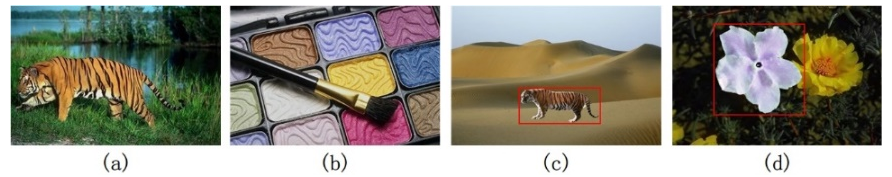
Figure 6. Examples of the images in CASIA ITDE V2.0. ( a , b ) Untampered images; ( c , d ) tampered images.